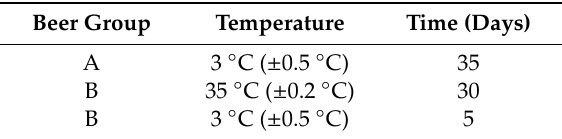
Table 1. Beer Group Time / Temperature Treatment